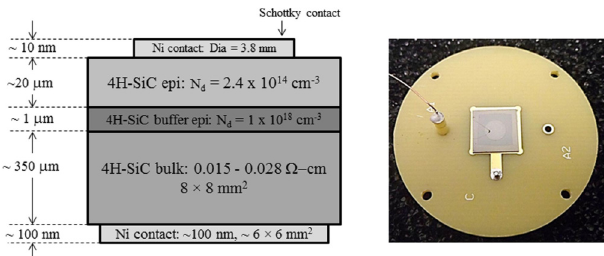
Figure 1. A cross-sectional schematic view of the epitaxial layer structure and a single pixel n-type Ni/4H-SiC Schottky barrier device (SBD) mounted on a printed circuit board (PCB). The square shaped back contact is visible through the wafer. The circular contact on the top is connected using a 25 µm thin gold wire.